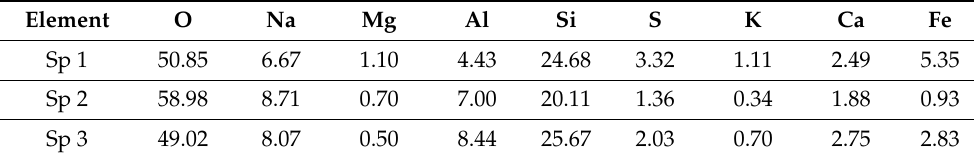
Figure 6. SEM secondary electron image of SZ ( left ) and corresponding SEM secondary electron image with three marked points for EDS analysis ( right ), both at a magnification of 5000 × . Table 7. Semi-quantitative chemical composition (given in wt %) of spherical clusters (Sp 1, Sp 3) and the surface of SZ (Sp 2).